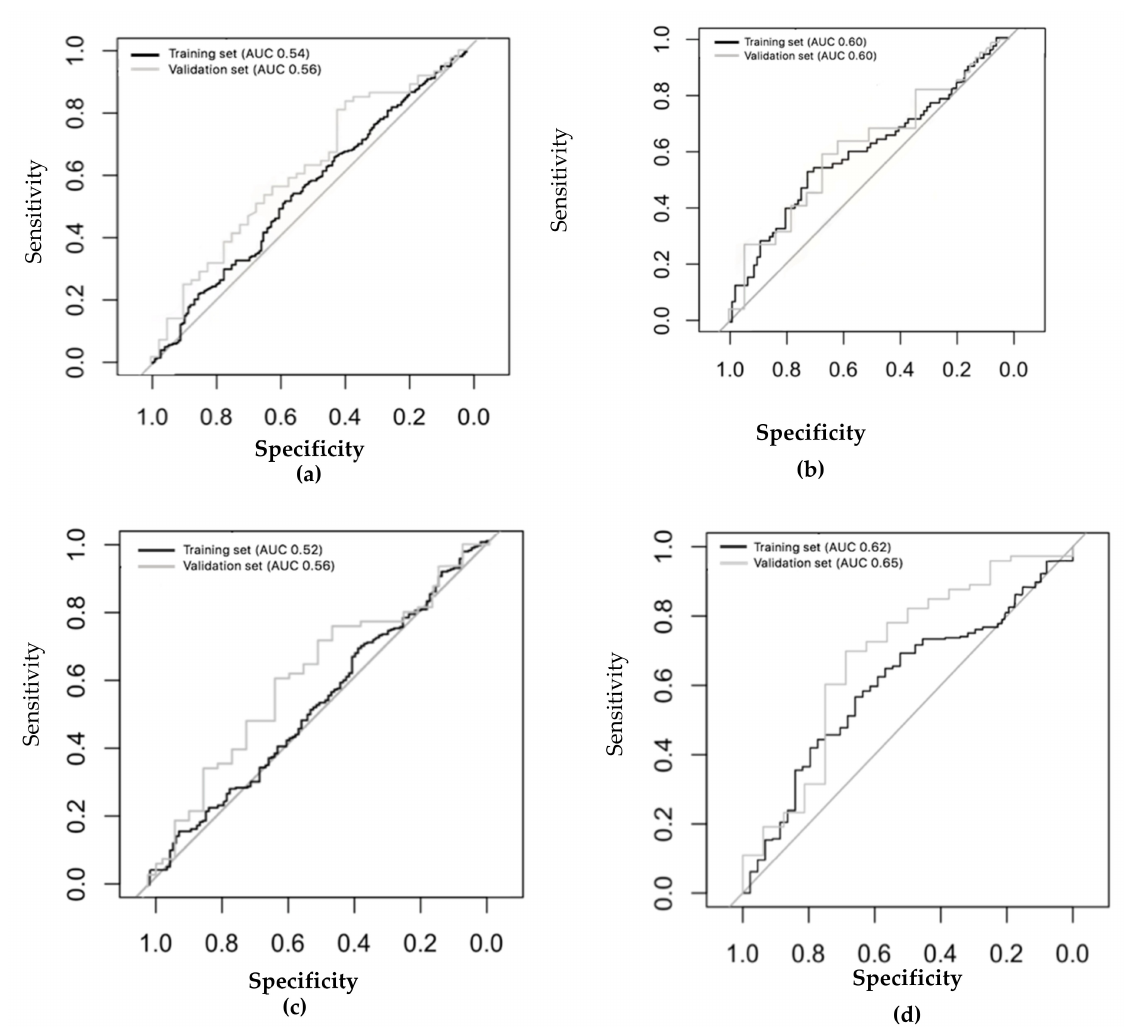
Figure 3. ROC analyses showing the accuracy of the linear discriminant model based on principal component reduction in the training set and the independent validation set for the healthy control group. ( a ) Ever-smokers in healthy subjects: training set (n = 452) AUC: 0.54 (95% CI: 0.49–0.60); validation set (n = 113) AUC: 0.60 (95% CI: 0.50–0.69). ( b ) Time of last cigarette consumption in healthy subjects (control: more than 24h; case: less than 24h) training set (n = 160) AUC: 0.60 (95% CI: 0.50–0.69); validation set (n = 39) AUC: 0.60 (95% CI: 0.42–0.70). ( c ) Ex- (n = 139) and never-smokers (n = 366): training set (ex-smokers = 116; never-smokers = 292), AUC: 0.52 (95% CI: 0.46–0.58); validation set (ex-smokers = 23; never-smokers = 74) AUC: 0.56 (95% CI: 0.46–0.60). ( d ) Active (n = 60) and never smokers (n = 366): training set (active smokers = 44; never-smokers = 292) AUC: 0.62 (95% CI: 0.51–0.67); validation set (active smokers = 16; never smokers = 74) AUC: 0.65 (95% CI: